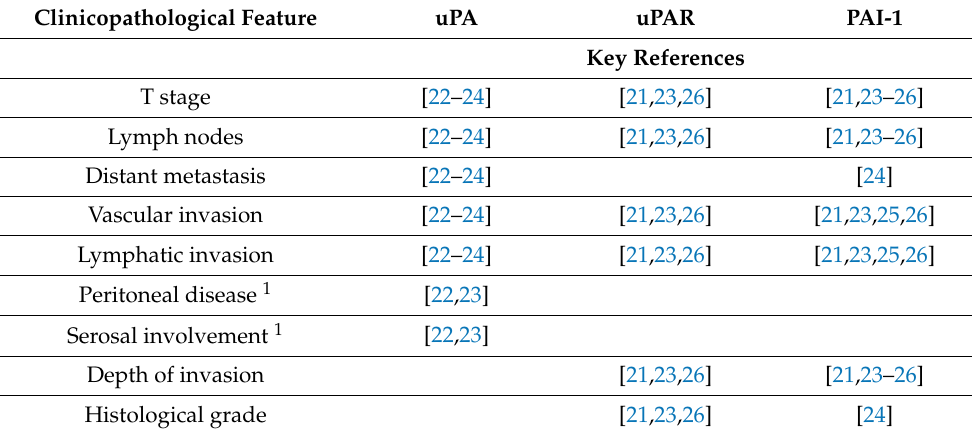
Table 2. Key references demonstrating the association of overexpression of each uPAS protein with clinicopathological